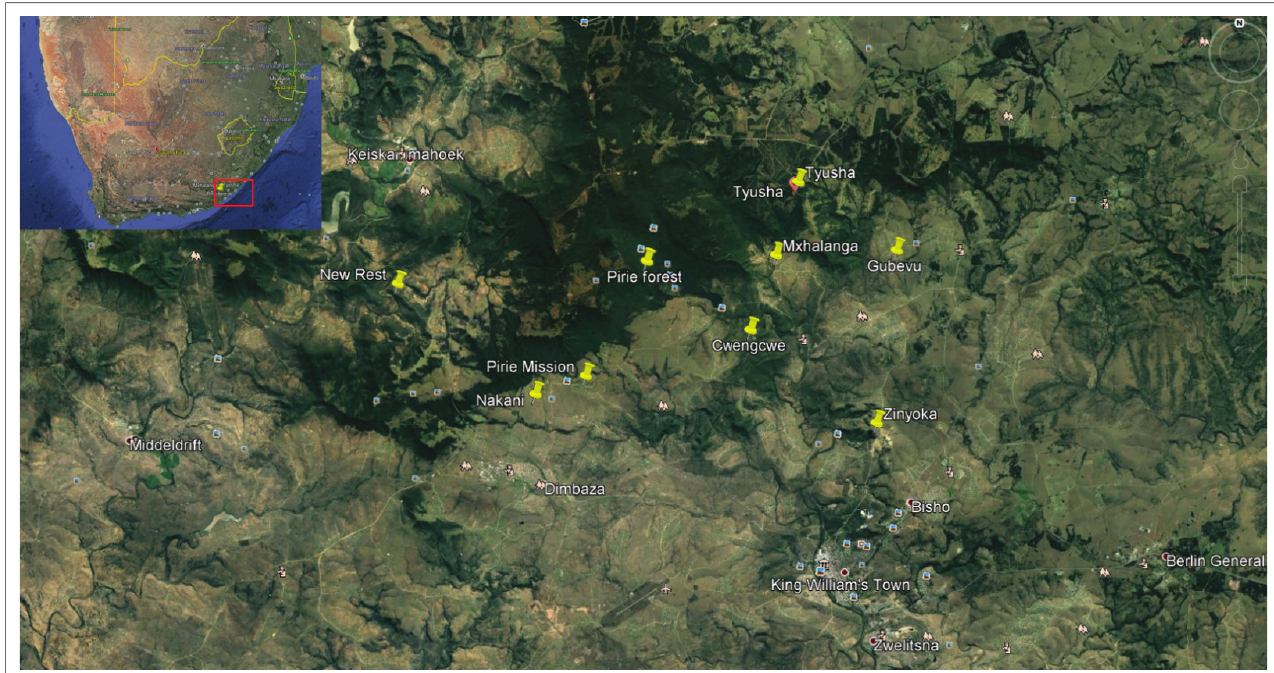
FIGURE 1: Map showing the Pirie forest and the locations of the villages in which the interviews were conducted. The yellow pins represent the communities in this